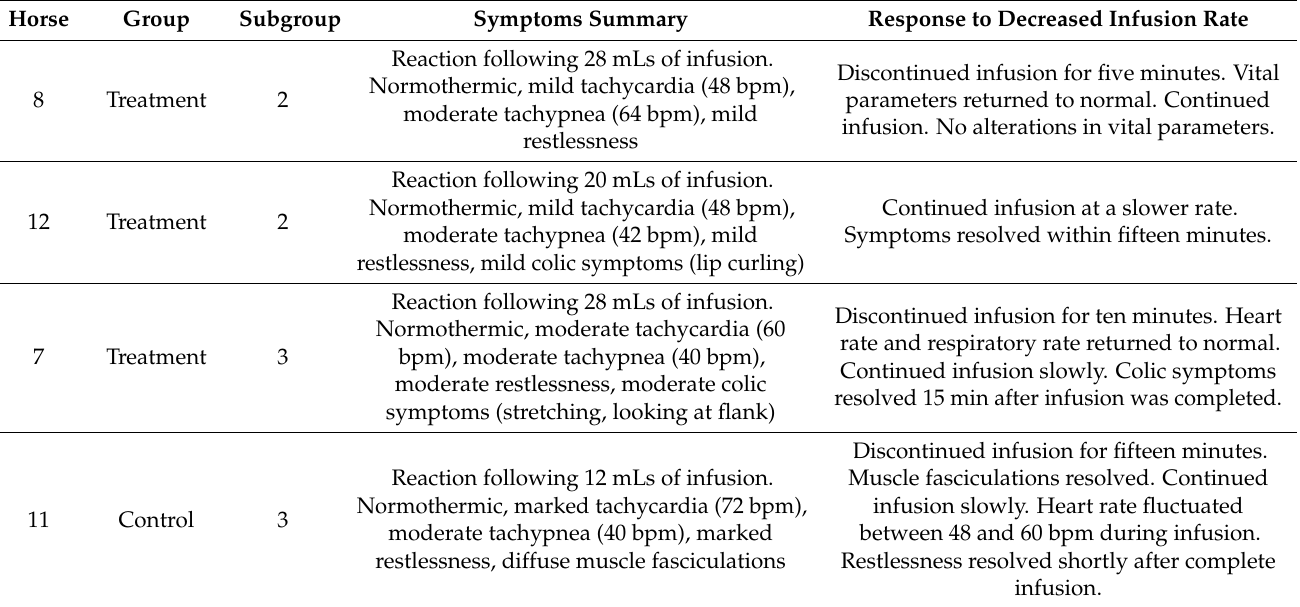
Table 2. Summary of adverse clinical responses following IV allo-CB-MSC administration.